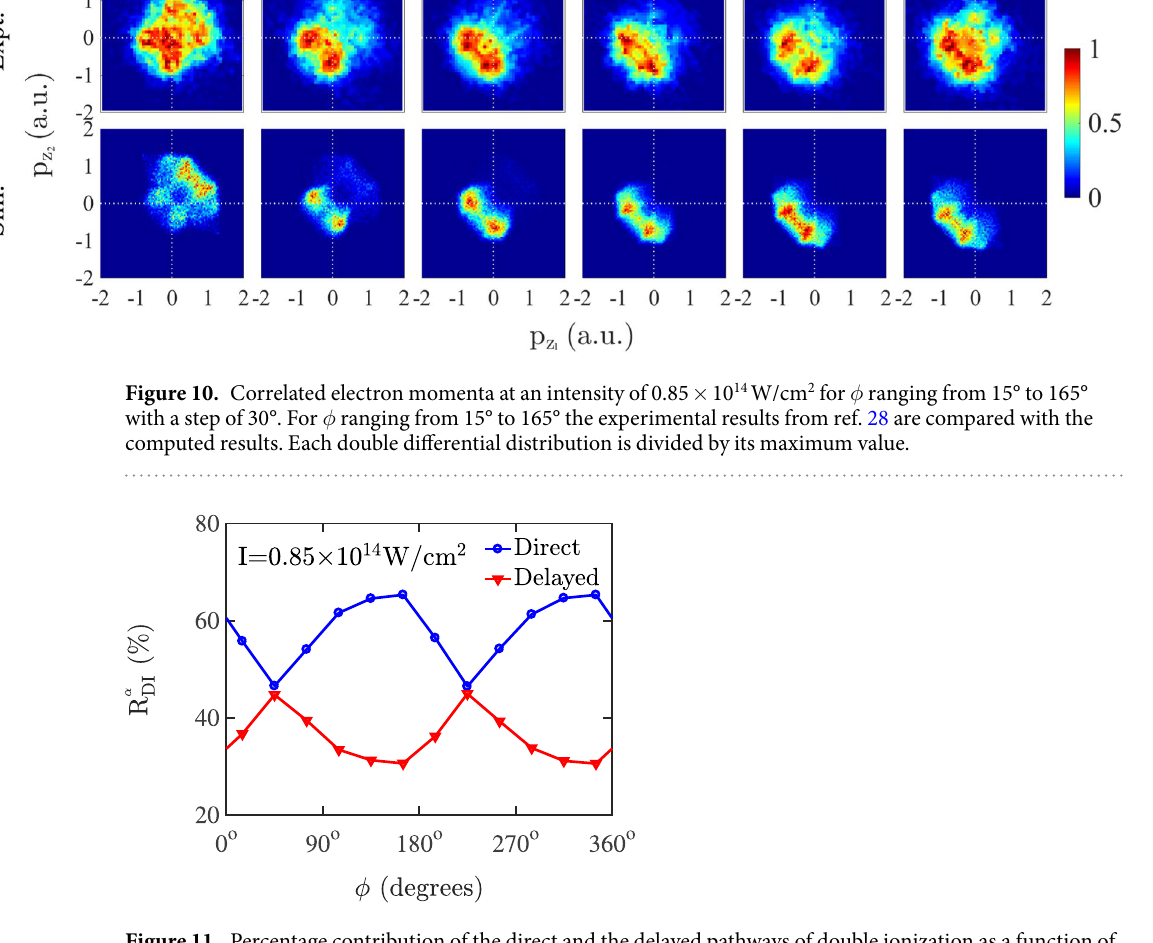
Correlated momenta and double ionization pathways as a function of CEP. In what follows, the dependence of the correlated momenta on the CEP is investigated at an intensity of 0.85 × 10 14 W/cm 2 . In Fig. 10, the correlated momenta are plotted for φ ranging from 15° to 165° with a step of 30°. The bin size of the CEP is chosen to be larger than 200 mrad, which is the experimental precision of the CEP, and large enough in order to get good statistics. For data analysis, all events are selected for which one electron has been detected in coinci- dence with an Ar 2 + ion. The momentum of the second electron, which is not detected for most events, is calcu- lated from conservation of momentum. Both the data and the computed results are symmetrized with respect to the bottom-left-to-top-right diagonal in order to account for the two electrons being indistinguishable. Moreover, due to the symmetry of the Hamiltonian, when φ → φ + 180° then p → − p . This symmetry is respected by the computed results. In the experimental results there is a small deviation from this symmetry. This deviation arises from artifacts of the electron spectrometer and false coincidences. For each CEP, in the top right half of the cor- related electron momenta plot the impact of false coincidences is stronger than in the bottom left half. For CEP ranging from 195° to 345° the correlated electron momenta plots have more doubly-ionized events in the top right half. Thus, in Fig. 10, we compare the computed results with the measured correlated electron momenta which are more accurate, i.e. for CEP ranging from 15° to 165° where the correlated electron momenta have more doubly-ionized events in the bottom left half. A good agreement is found between the computed and the experimental results for CEP ranging from 15° to 165° given the experimental uncertainty of 200 mrad in the CEP. Specifically, the computed correlated momenta correctly reproduce the overall observed pattern for each individual CEP. A difference between the computed and the experimental results is that the former results have less doubly-ionized events with both electron momenta close to zero suggesting that the computations overestimate the contribution of the direct pathway. To better illustrate the change of the correlated momenta pattern as a function of the CEP plotted in Fig. 10, in Fig. 11 the percentage of the direct and delayed pathways of double ionization are plotted as a function of the CEP. At an intensity of 0.85 × 10 14 W/cm 2 the delayed pathway has the largest contribution for CEPs φ = 45° and φ = 225°,